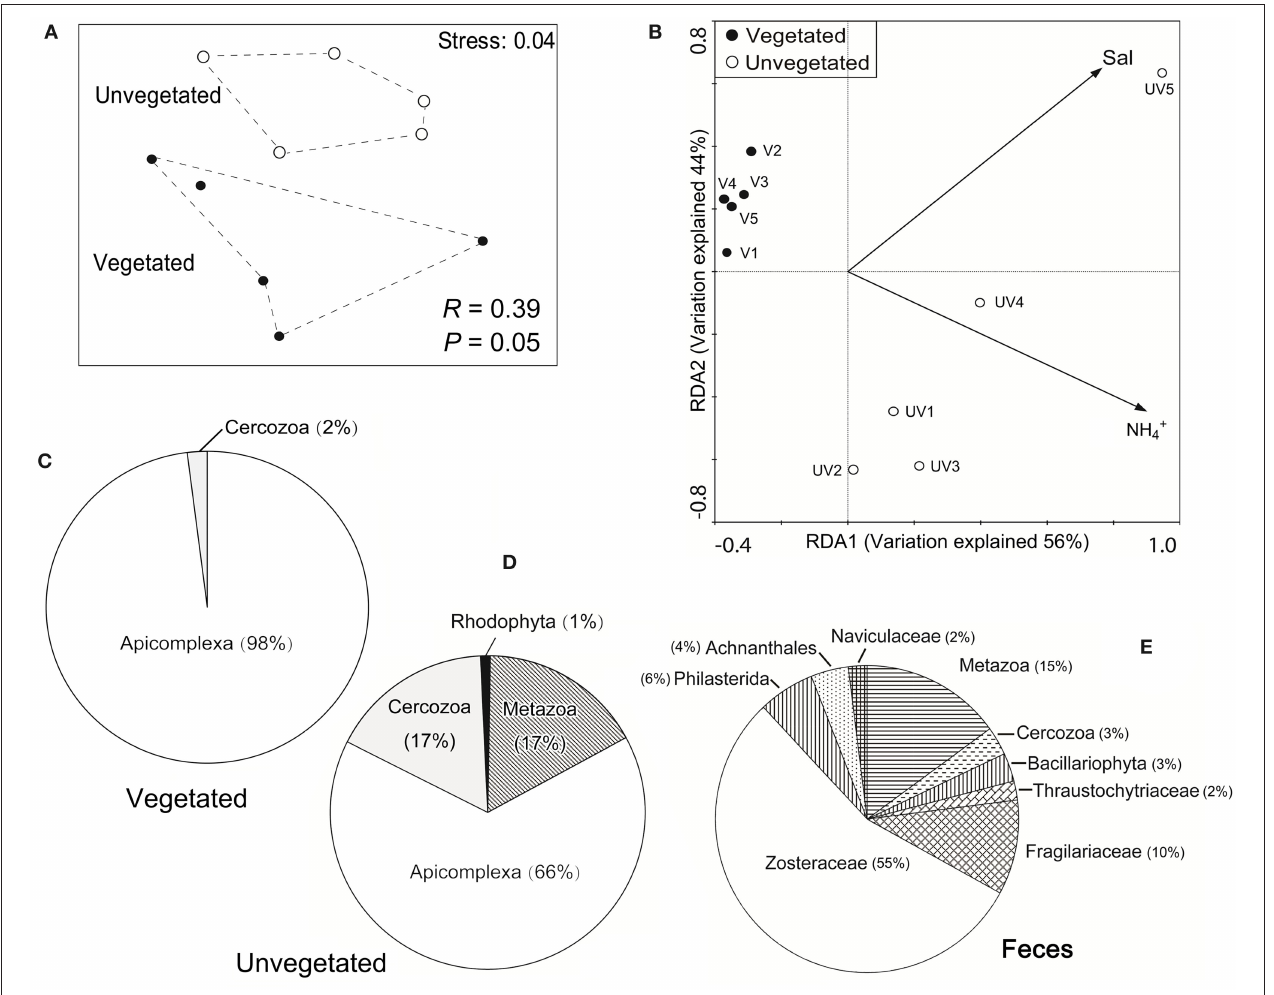
FIGURE 3 | (A) A plot of non-metric multidimensional scaling, showing that the community structure of benthic microeukaryotes was significantly different in the vegetated and unvegetated sediment types; (B) a plot of redundancy analysis (RDA), indicating that the changes in microeukaryotic community structure covaried significantly with the concentration of ammonium and salinity across all the 10 sites (Monte Carlo tests, P < 0.05); and (C–E) pie plots showing the sequence proportions of major eukaryotic taxa based on 18S rRNA gene clone libraries derived from the vegetated (C) , unvegetated (D) , sediments, and from swan feces (E)